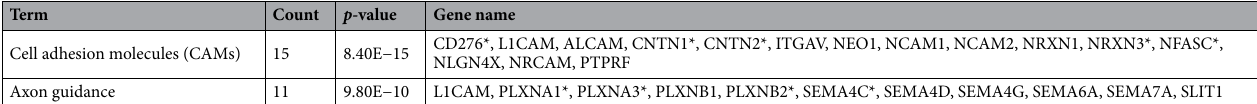
Table 1. KEGG pathway analysis of the HN 5 H 3 F-modified proteins in the DAs. *The presence of diagnostic ion for bisecting GlcNAc was confirmed in the product ion